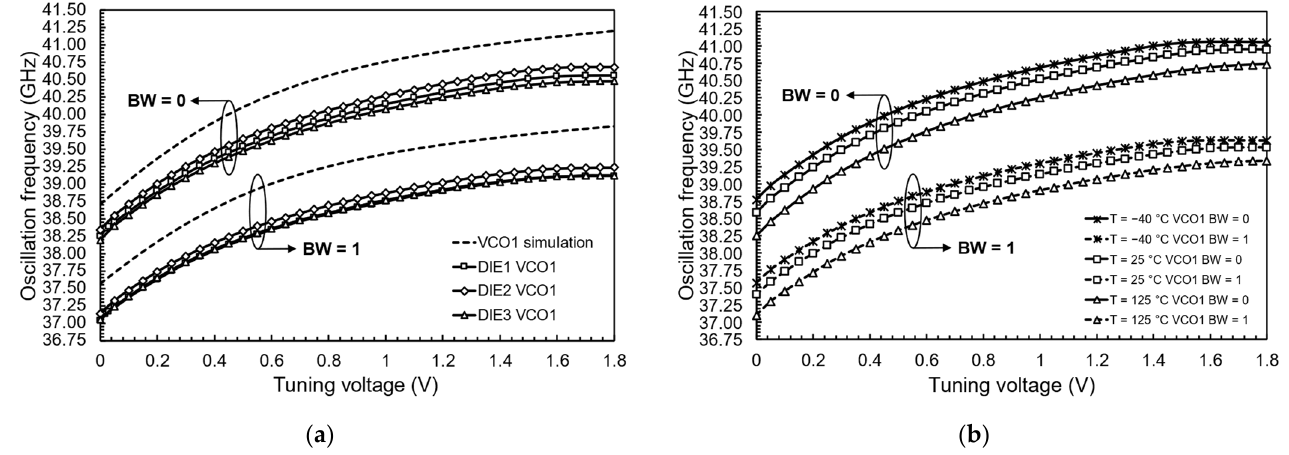
Figure 8. Measured VCO tuning range: ( a ) simulations and measurements over three dice at T = 25 °C; ( b ) measurements at three different temperatures.